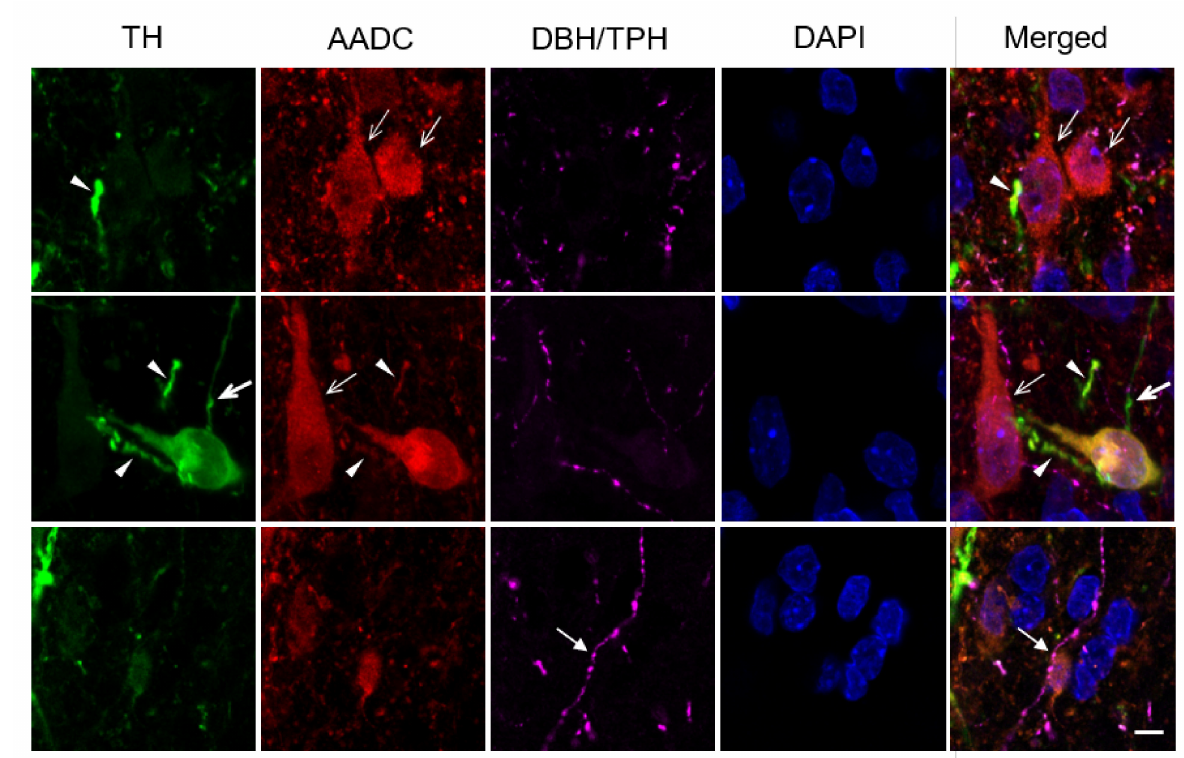
Figure 4. Observations in a confocal microscope of contacts of nerve fibers immunopositive only for tyrosine hydroxylase (TH+, green, thick arrow), only for aromatic L-amino acid decarboxylase (AADC+, red, thin arrow), for both enzymes (TH+/AADC+, yellow, arrowhead), as well as nerve fibers immunopositive for tryptophan hydroxylase (TPH) and/or dopamine- β -hydroxylase (DBH) (purple, closed arrow) with cell bodies and proximal processes of neurons TH+/AADC − (green), AADC+/TH − (red), and TH+/AADC − (yellow)) in the PeVN in rats. Scale: 5 µ m; × 63. All the populations of neurons—TH+/AADC − , TH − /AADC+, and TH+/AADC+— were found at all levels of the PeVN in the rostro-caudal axis, but the number of neurons in these populations at different levels of the PeVN differed significantly (Figure 7). Thus, throughout the PeVN in the rostro-caudal direction (240–960 µ m), except for the most caudal level (1200 µ m), TH − /AADC+ neurons quantitatively dominated. At three rostral levels of the PeVN (240–720 µ m), the number of TH+/AADC − and TH+/AADC+ neurons was approximately the same, but was many times lower than the number of TH − /AADC+ neurons. At caudal levels three to six (720–1200 µ m), the number of TH+/AADC − and TH+/AADC+ neurons increased, while the number of TH − /AADC+ neurons decreased. At the most caudal level of the PeVN, TH+/AADC − neurons predominated, while the numbers of TH − /AADC+ and TH+/AADC+ neurons became equal (Figure